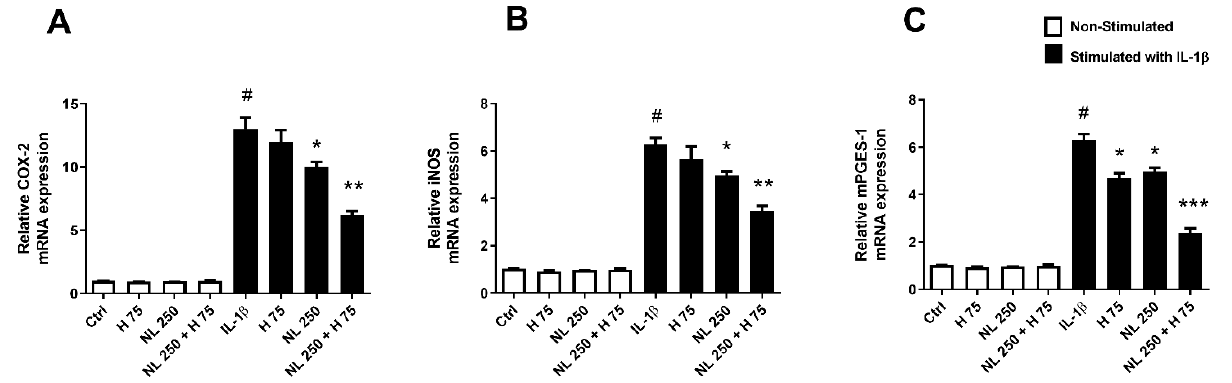
Figure 6. Influence of hop extract, empty nanoliposomes, and nanoliposomes encapsulating hop extract on inflammation marker transcription in vitro. Human chondrocytes were stimulated or not with 1 ng/mL IL-1 β and exposed to hop extract alone (75 µ g/mL), empty nanoliposomes (250 µ g/mL rapeseed lecithin), or nanoliposomes encapsulating hop extract (respectively at 250 µ g/mL rapeseed lecithin and 75 µ g/mL). The culture conditions were performed for 6 h for early inflammation markers (COX-2 and iNOS mRNA) and 24 h (mPGES-1 mRNA). Total RNA was extracted, then reverse transcribed into cDNA, and finally analyzed by real-time PCR. The relative abundance of transcripts of ( A )